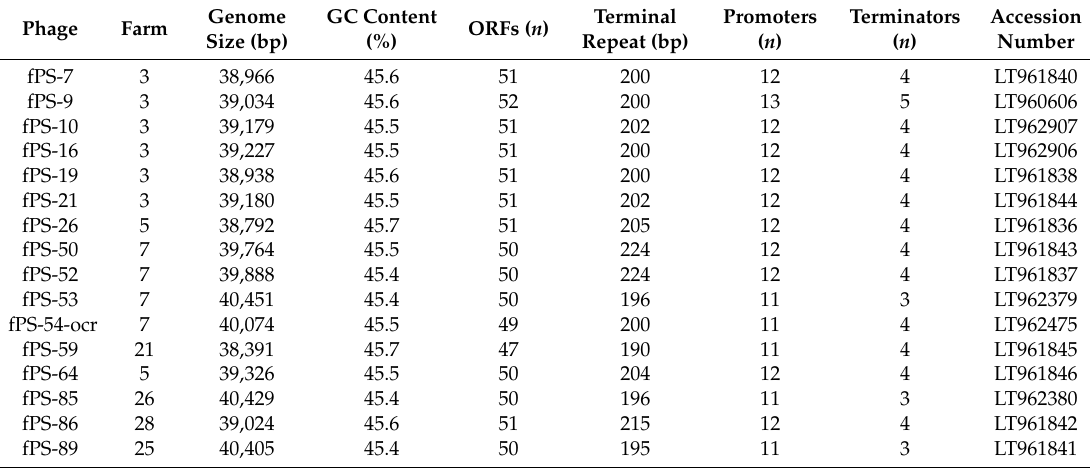
Table 2. Characteristics of the Y. enterocolitica specific